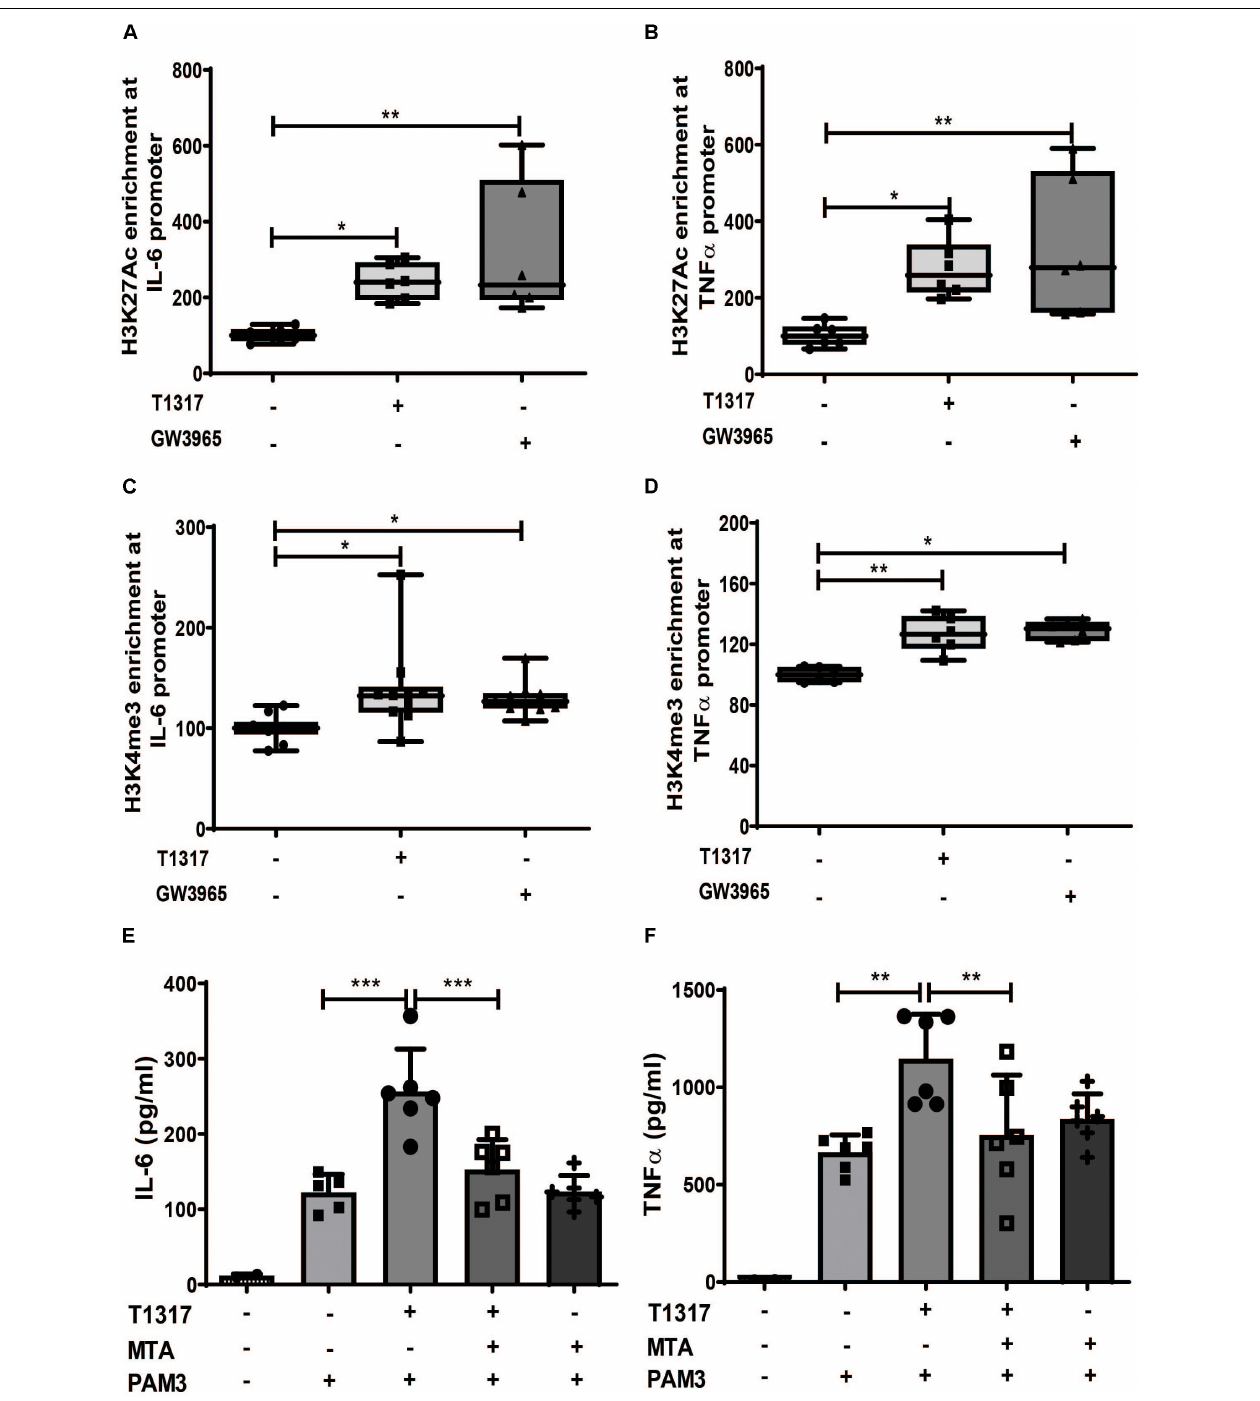
FIGURE 2 | LXR priming induces epigenetic reprogramming. (A–D) Monocytes were treated as indicated with 2 µ M T1317 (LXR agonist), 10 µ M GW3965 (LXR agonist) or vehicle for 24 h and kept for 5 days in complete medium. Chromatin was collected and ChIP assay was performed using an antibody against histone H3 acetylated at lysine 27 (H3K27ac), histone H3 trimethylated at lysine 3 (H3K4me3) or control IgG. Then quantitative real-time PCR was performed with primers for IL-6 (A,C) and TNF α (B,D) . (E,F) Monocytes were treated as indicated with 2 µ M T1317 (LXR agonist), 20 µ M MTA (histone methyltransferase inhibitor) or vehicle for 24 h, kept for 5 days in complete medium and restimulated with 5 µ g/ml Pam3cys for 24 h. IL-6 (E) and TNF α (F) were measured in the supernatant. Graphs represent mean values ± SD of six individuals in three different experiments. * P < 0.05, ** P < 0.01, and *** P < 0.001.